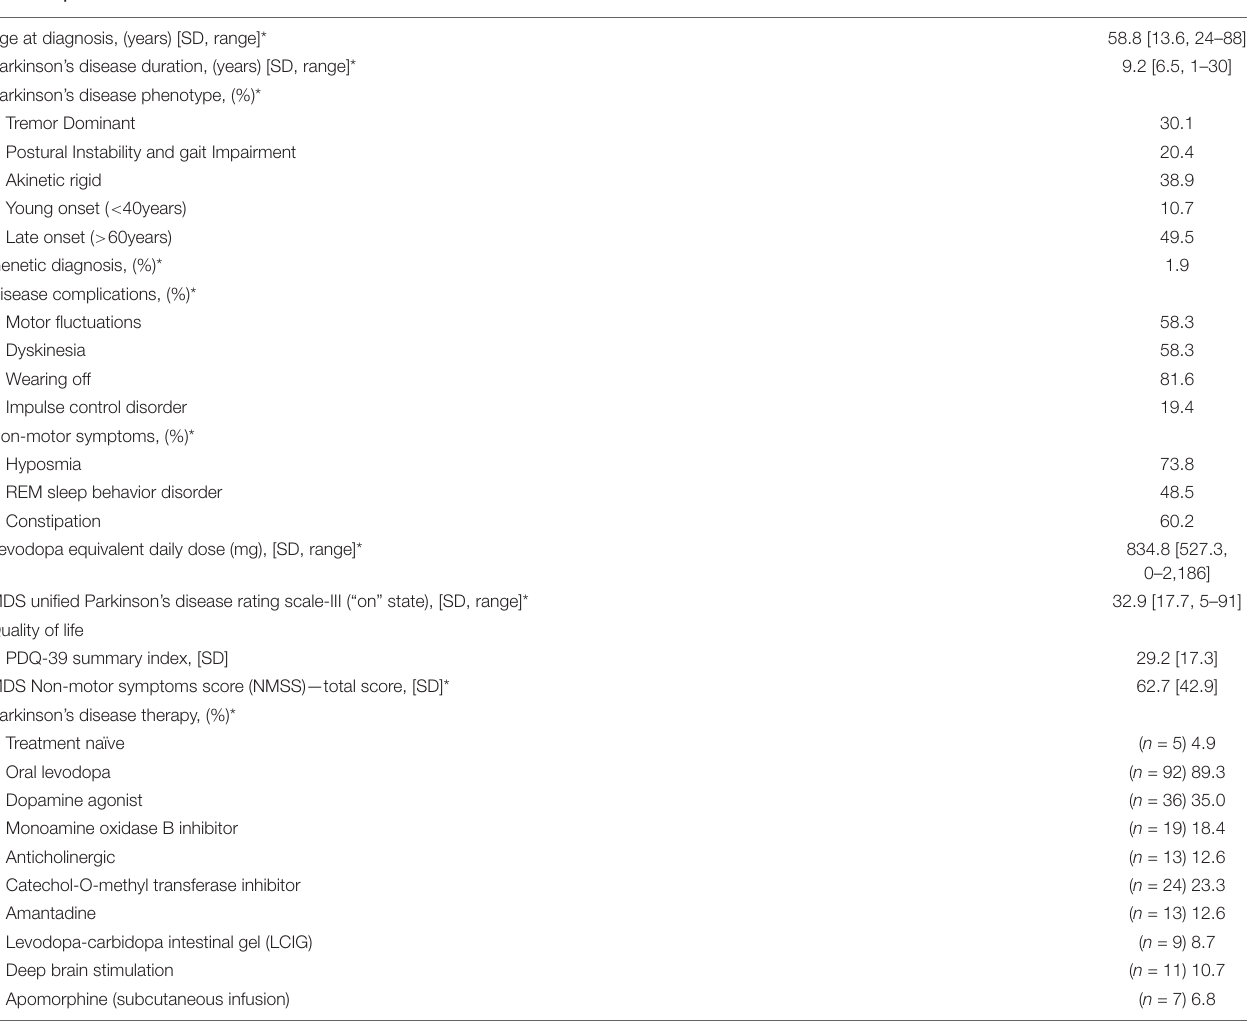
TABLE 2 | Parkinson’s disease clinical